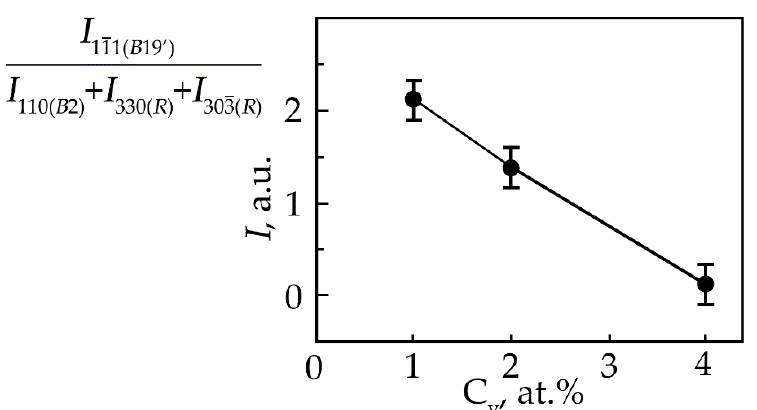
_ 1 ) from the martensitic phase with the Figure 4. Dependence of the ratio of reflection intensities ( 11 Figure 4. Dependence of the ratio of reflection intensities (111) from the martensitic phase with the В19′ structure to the total intensity of the (330) and (30 3 ) R-phase reflections, which form a doublet B19 (cid:48) structure to the total intensity of the (330) and (303) R-phase reflections, which form a doublet upon splitting of the (110) reflection of the В2 phase at room temperature in TiNi alloys doped with upon splitting of the (110) reflection of the B2 phase at room temperature in TiNi alloys doped with vanadium, on the concentration V. vanadium, on the concentration